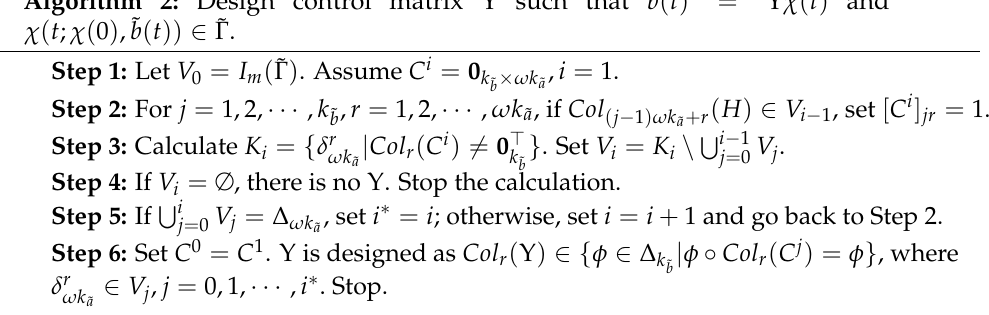
Algorithm 2: Design control matrix Υ such that ˜ b ( t )